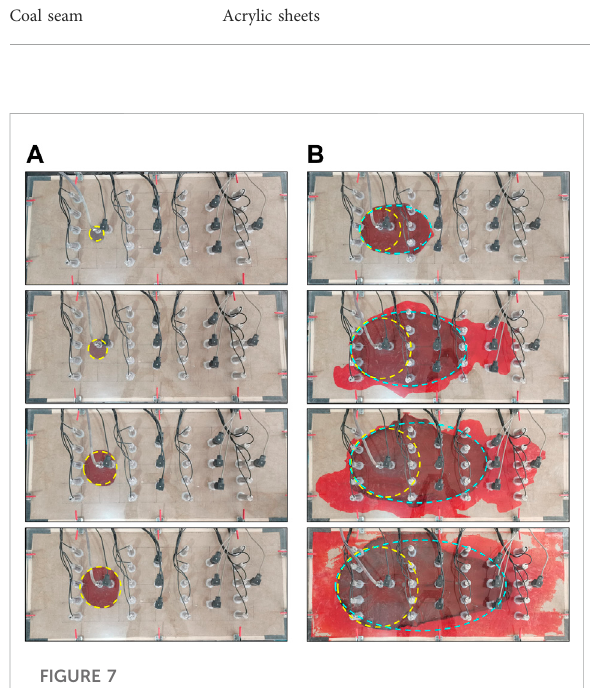
FIGURE 7 Slurry diffusion. (A) Radial fast diffusion (0 – 2.5 min), (B) strike direction diffusion (2.5 – 45